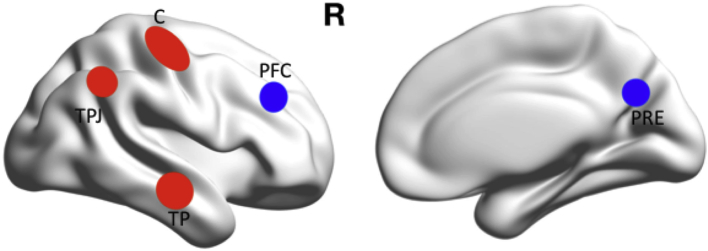
Regions of interest (ROIs). Increased source activity at the epileptic foci in the central (C) region has been reported in the literature and this increased activity extended to the ipsilateral temporo-parietal junction (TPJ) and temporal pole (TP) of the epileptic foci. However, lower activity was reported at the frontal region (prefrontal cortex – PFC), very close to the epileptic foci, and at the precuneus (PRE).